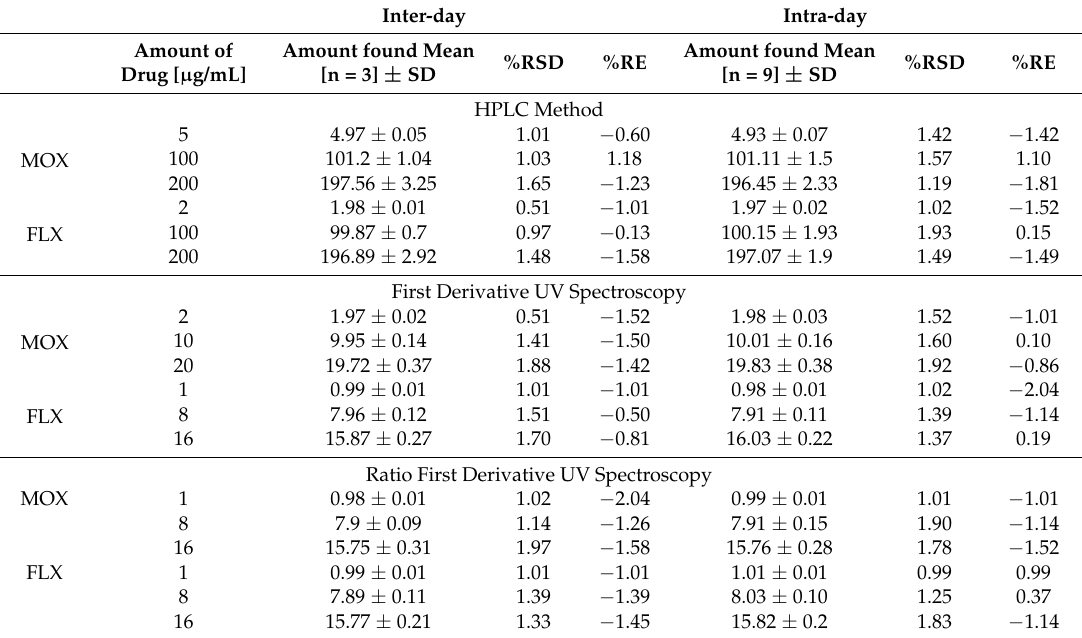
Table 2. Precision and accuracy